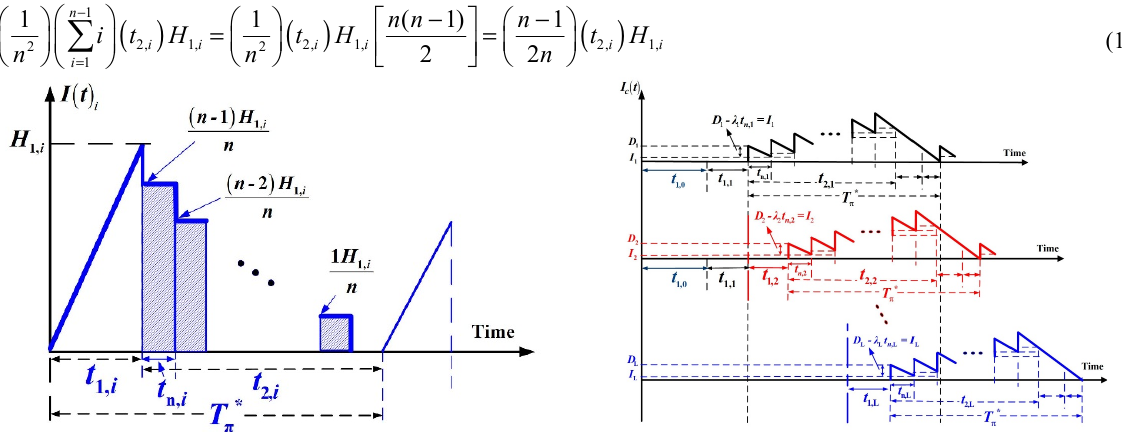
Fig. 4 . Each merchandise i ’s stock level in delivering time Fig. 5. Finished item i ’s stock level on the customer